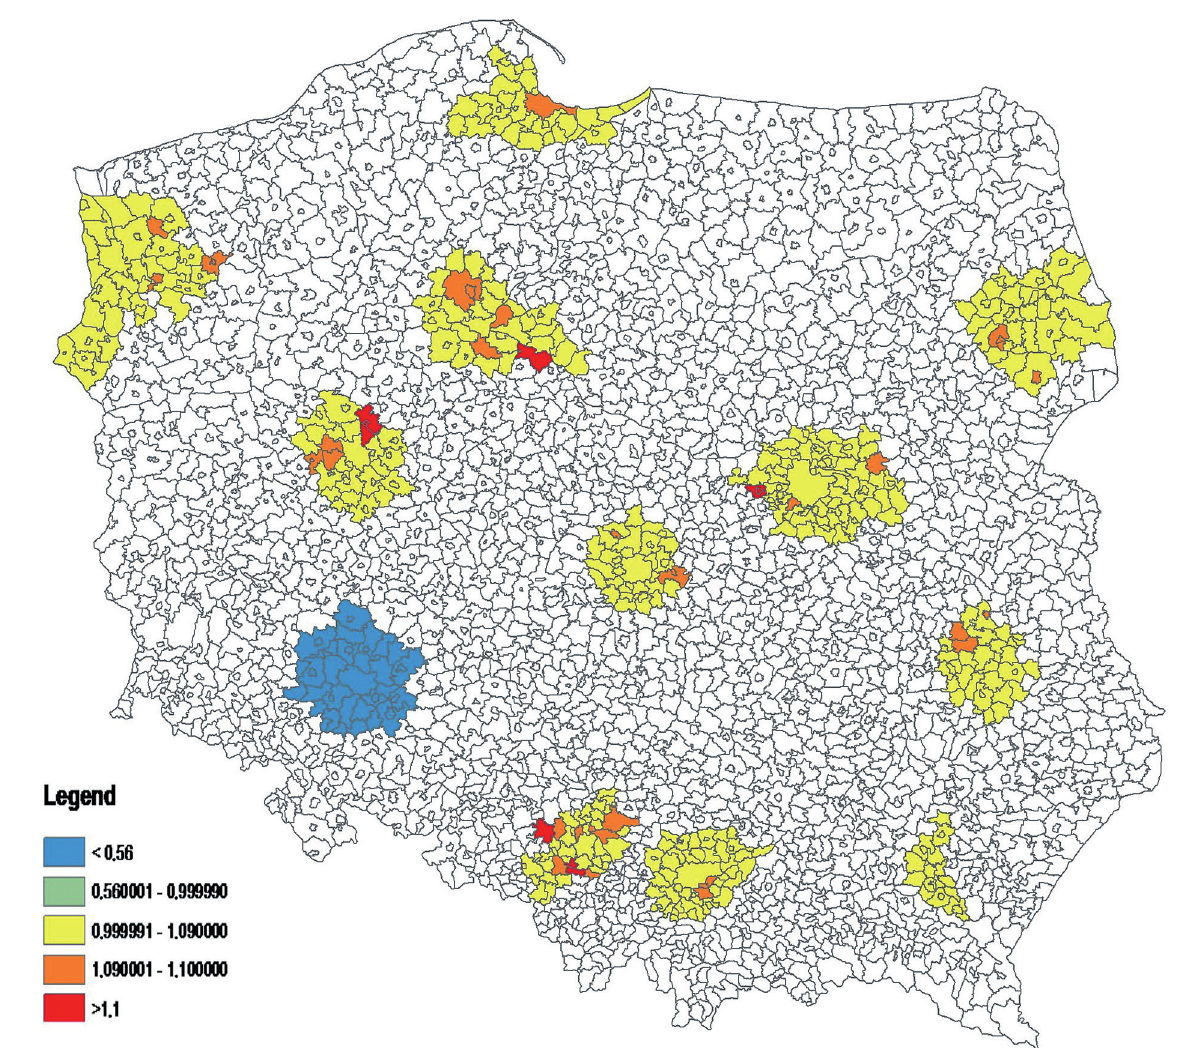
Fig. 4. Dynamics of entropy of the land use structure in municipalities of the metropolitan areas of Poland (2000/1990, see explanation in